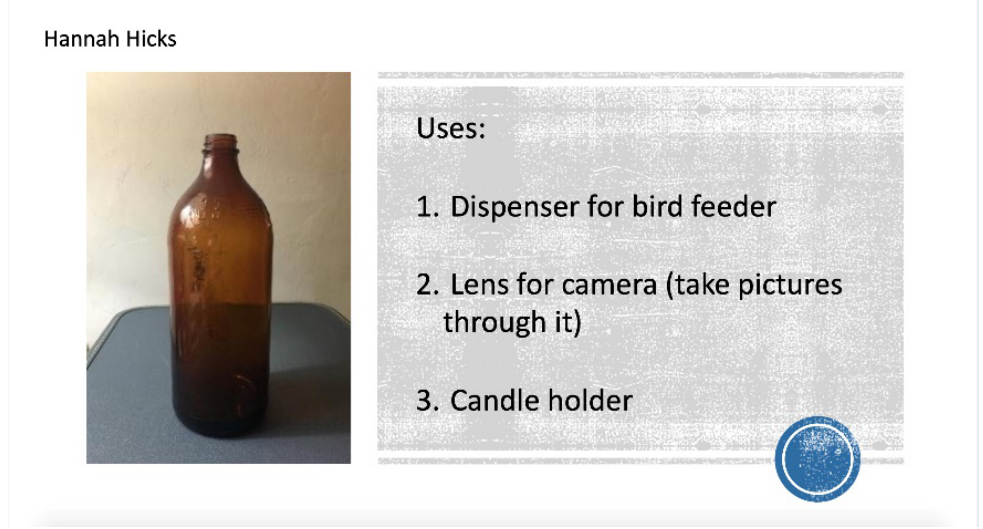
Figure 6. Repurposing Slide by Hannah Hicks Brown (2018).